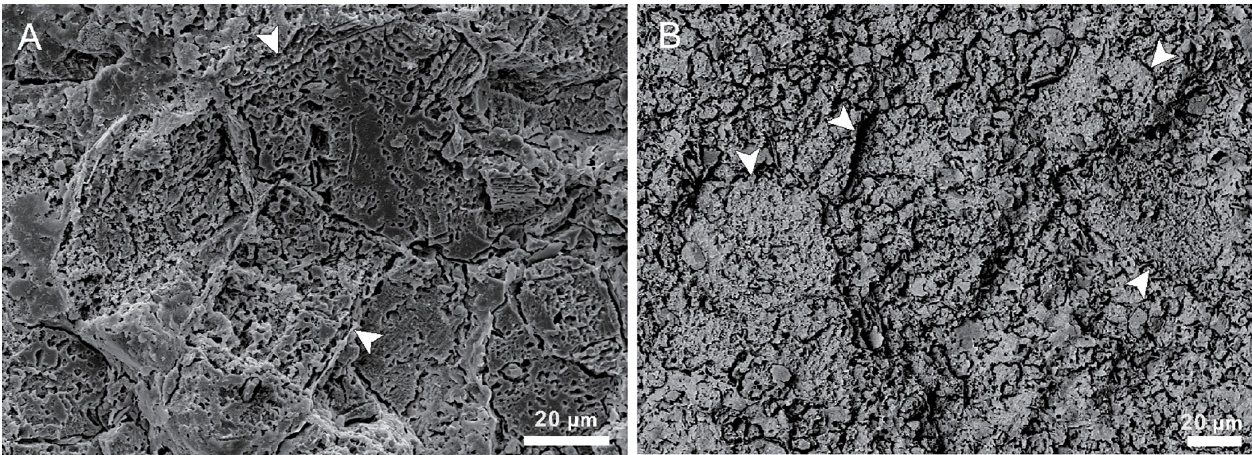
Fig 4. Scanning electron microscope images of Epiphyton within Cambrian thrombolites. (A) Regular rectangles (white arrow). (B) Spheres (white arrow) with fine grained calcite and external coatings, back scattered electron mode.